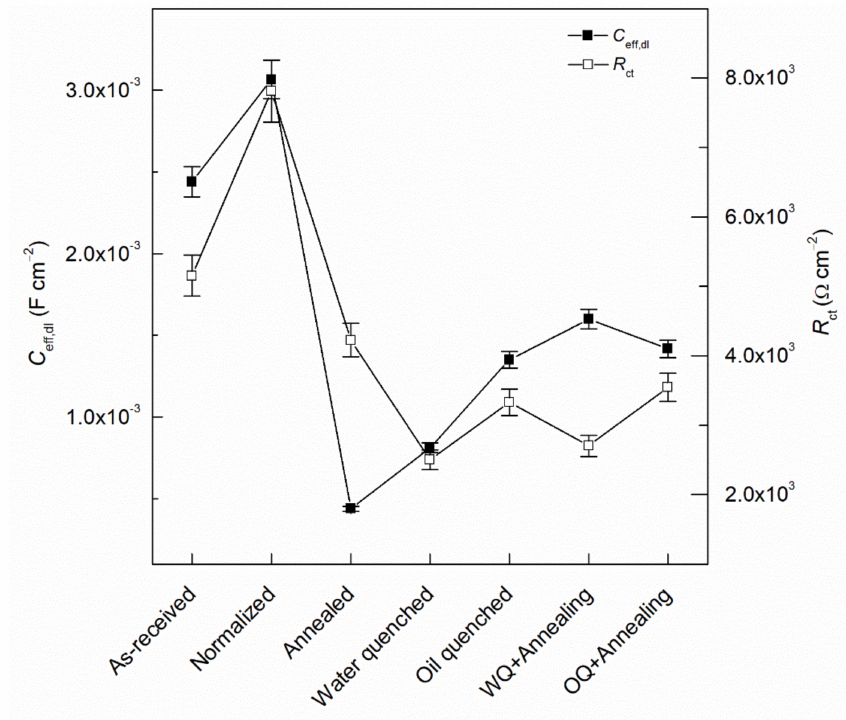
Figure 10. Evolution of C eff,dl and R ct parameters for each thermomechanical treatment in FA pore solution containing 0.6 M NaCl.